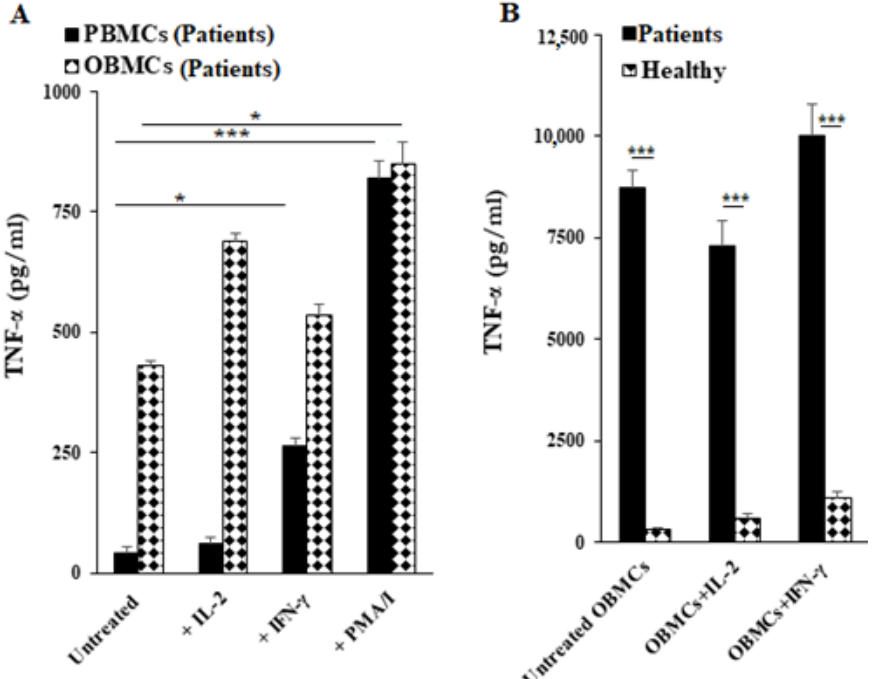
Figure 3. Periodontitis patients’ OBMCs secreted higher levels of TNF- α secretion in comparison to their PBMCs; Periodontitis patients’ OBMCs secreted higher levels of TNF- α when compared to those from healthy individuals. PBMCs and OBMCs of periodontitis patients were treated with IL-2 (500 U/mL), IFN- γ (500 U/mL) and PMA (10 ng/mL) + ionomycin (10 ng/mL). After 12–18 h of incubation, supernatants were harvested and the levels of TNF- α secretion were determined using single ELISA. *** ( p value < 0.001), * ( p value 0.01–0.05), p values were obtained for differences between untreated or IL-2 or IFN- γ treated PBMCs and OBMCs obtained from the periodontitis patients ( A ). OBMCs obtained from healthy individuals and periodontitis patients were left untreated, treated with IL-2 (500 U/mL) or treated with IFN- γ (500 U/mL). After an overnight incubation the supernatants were harvested and subjected to a single ELISA to determine TNF- α secretion levels. *** ( p value < 0.001), p value was obtained for the difference between TNF- α secretion by OBMCs obtained from healthy individuals and periodontitis patients; control, IL-2 and IFN- γ treated OBMCs ( B ). One of four representative experiments is shown in this figure.